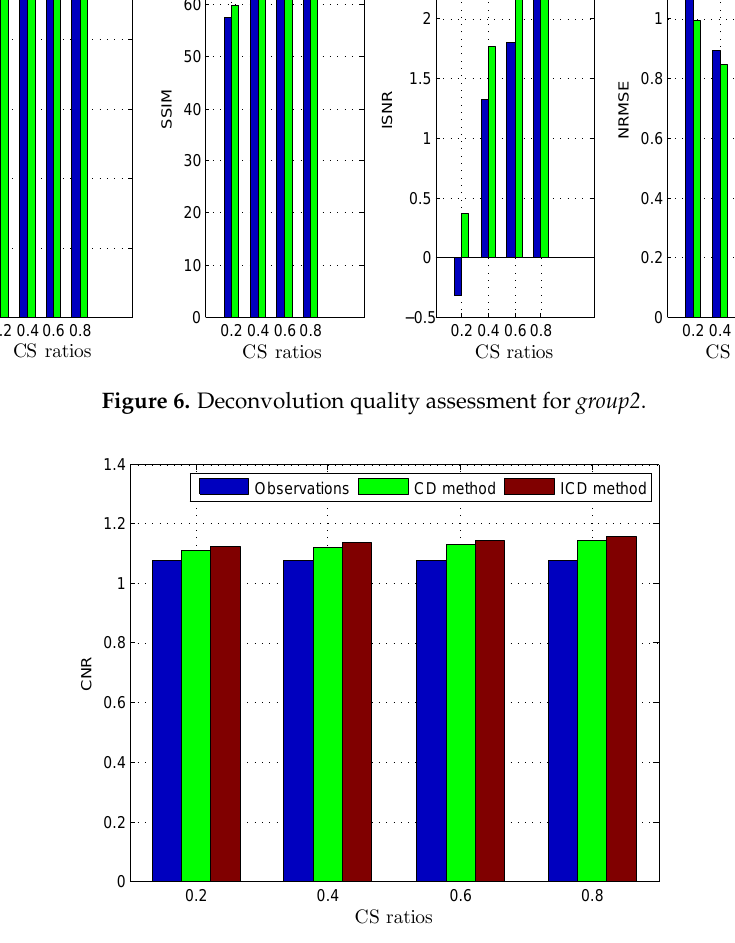
Figure 7. Deconvolution quality assessment for Mouse bladder